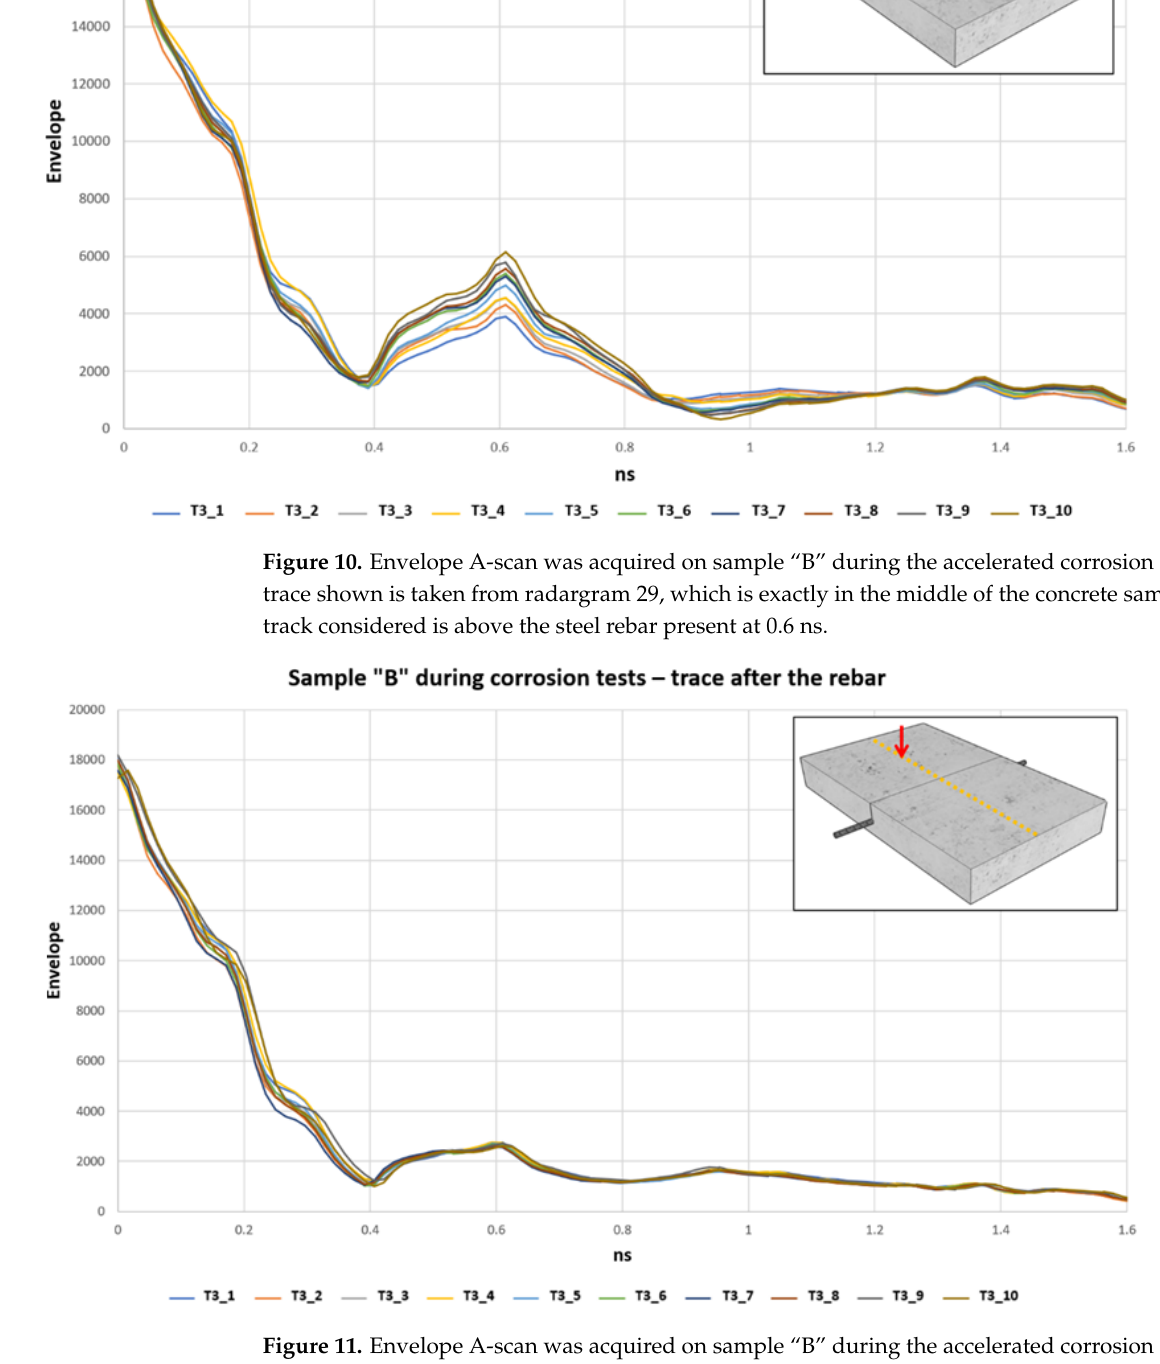
Figure 12. Envelope A-scan was acquired on sample “B” during the accelerated corrosion test. The trace shown is coming from the radargram n°29, 10 cm before the steel rebar. From the graph, we can see that there were no changes in the envelope A-scan trace during the corrosion test. 3.4. Sample “B” Wet Sample after Corrosion Tests After 10 days of accelerated corrosion test, a small fracture was observed at the upper side of the sample. Therefore, the injection of the current was stopped. After the current stop phase, for 5 days, new acquisitions were carried out to observe the values of the en- velope signal around the steel rebar. The investigations carried out at this stage are indi- cated with T4. They were performed every day, and each one is shown in Figure 13 as